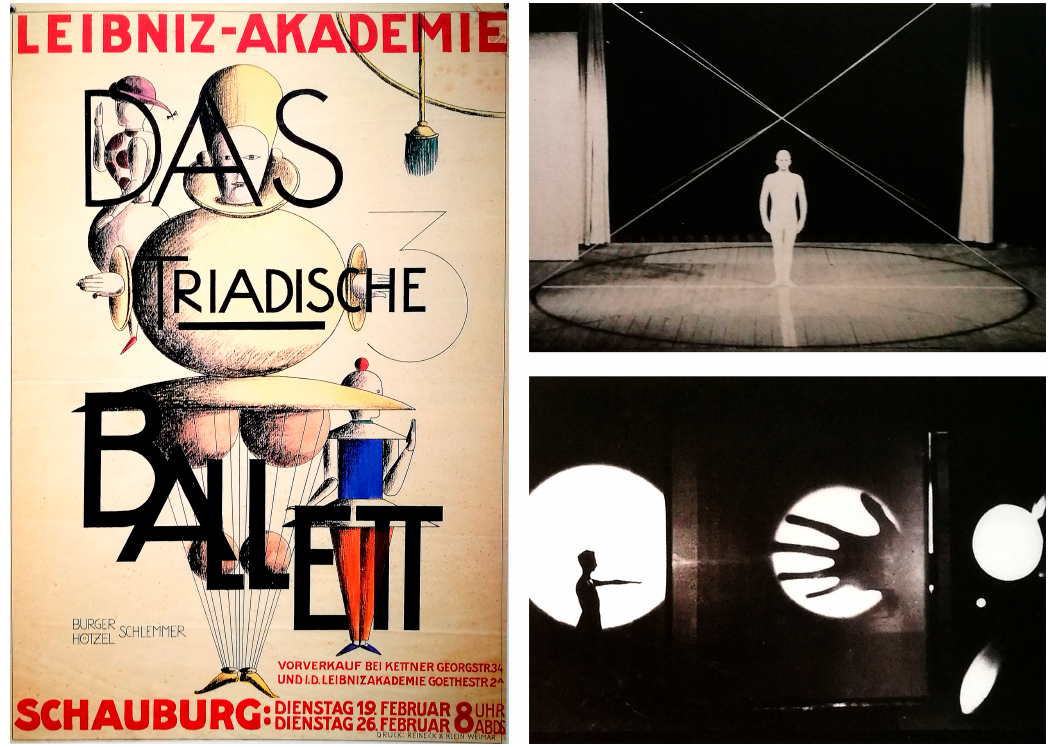
Figure 5. On the left , O. Schlemmer, Das Triadische Ballett , Hannover, 1924; above on the right ,